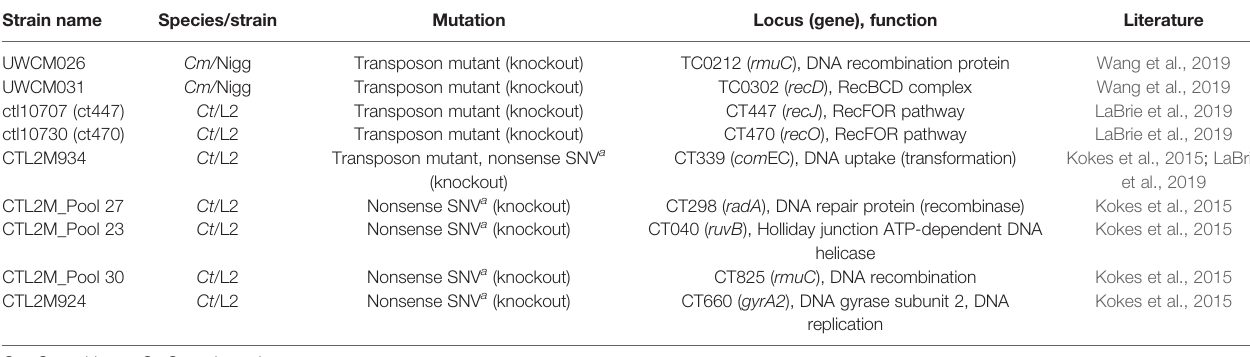
TABLE 1 | List of knockout mutants concerning genes involved in lateral gene